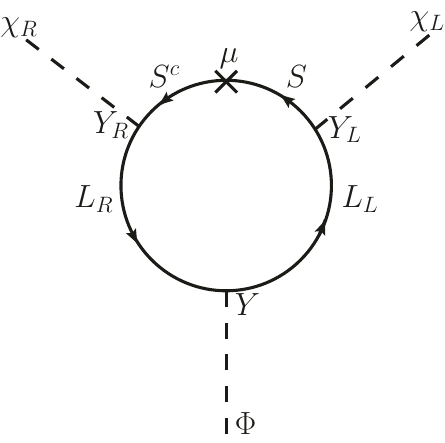
Figure 1 . 1-loop diagram generating (cid:31) y